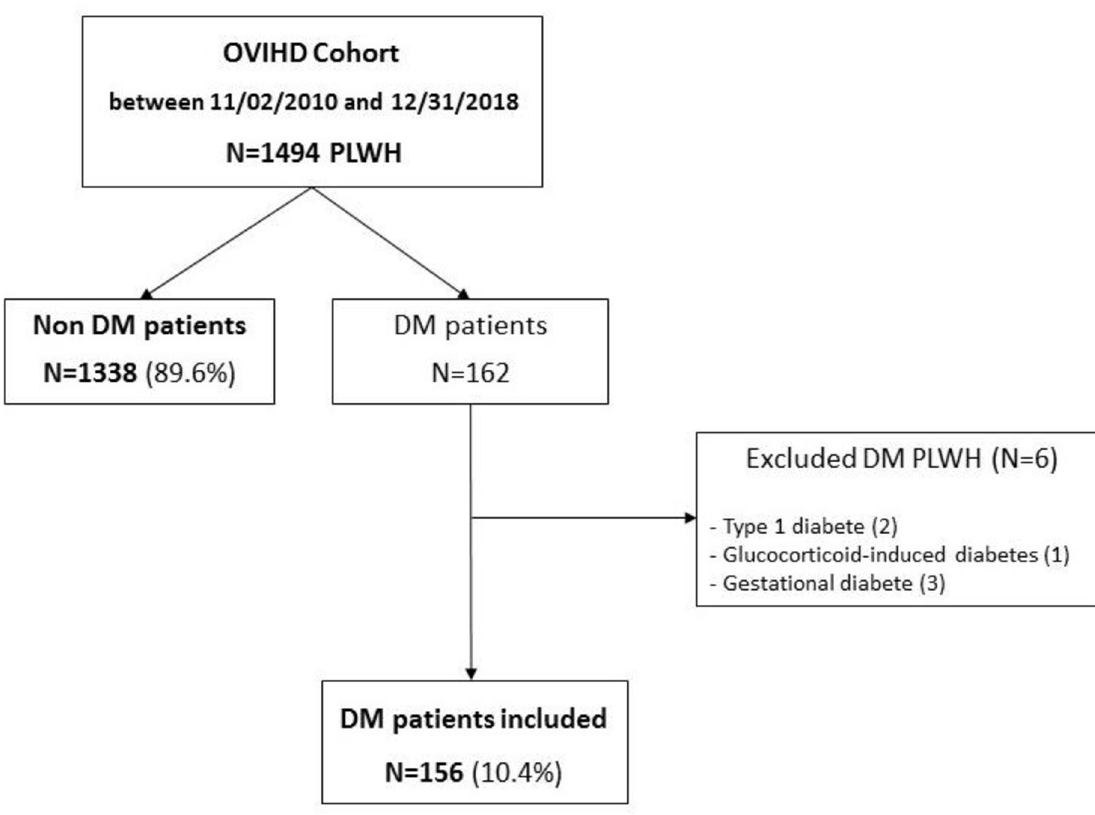
Fig 1. Flow chart of the study population. OVIHD: Observatoire VIH de l’Hoˆtel-Dieu; PLWH: People living with HIV; DM: Diabetes mellitus.